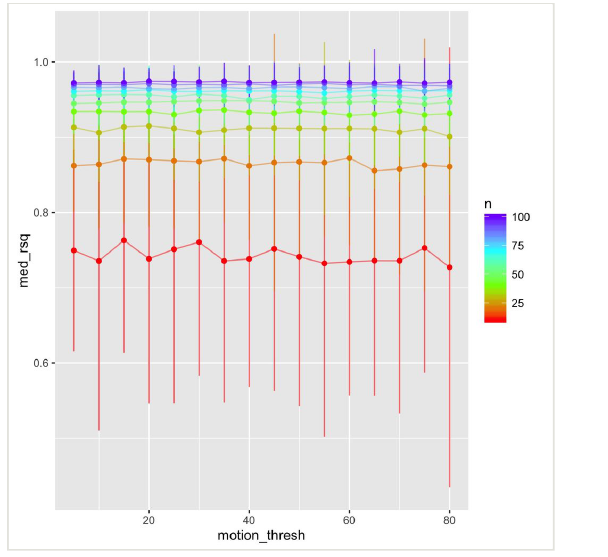
Split-half reliability results showing how sample size (N) has a large e ff ect on R squared (median R squared from 100 permutations) while motion threshold does not. Error bars represent average 95% con fi dence intervals across 100 permutations. Code and output can be found on GitHub (Flournoy and Leonard